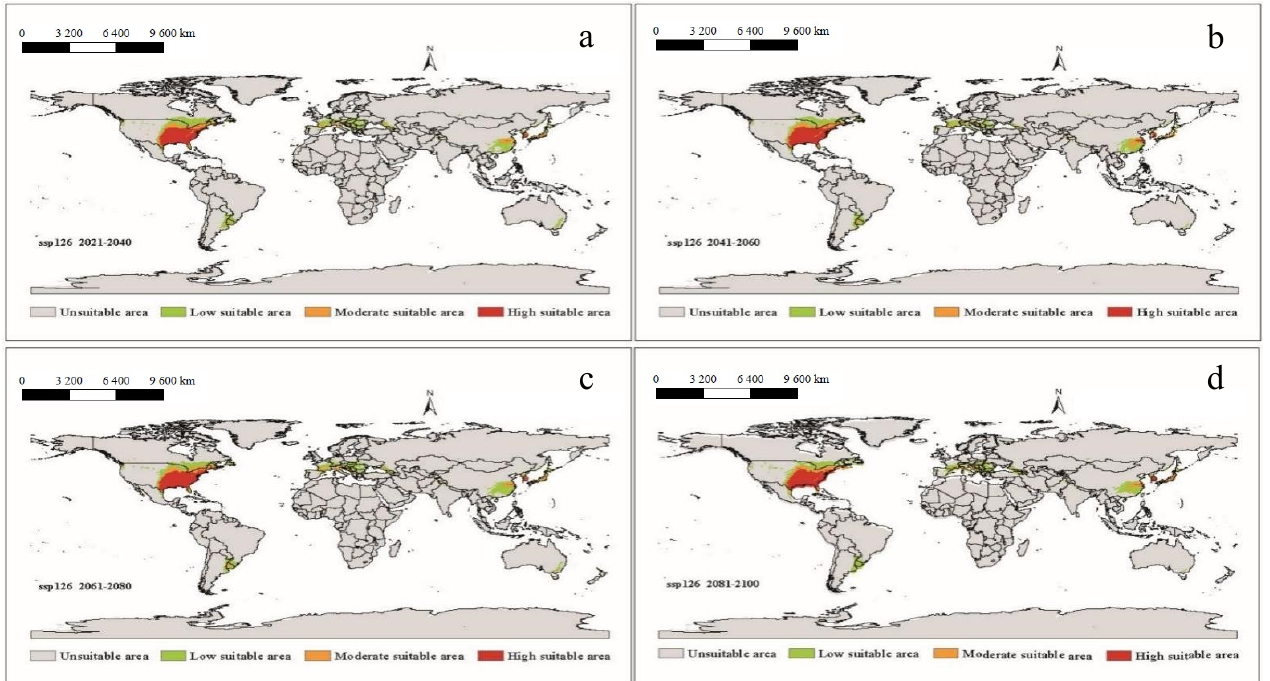
Figure 6. The potential distribution of suitable areas for A. americanum around the world under the climatic conditions of shared socio-economic pathway 1-2.6 (sustainability and radiative forcing of 2.6 W/m 2 to 2100) during different periods of the 21st century: ( a ) 2021–2040, ( b ) 2041–2060, ( c ) 2061–2080 and ( d ) 2081–2100.